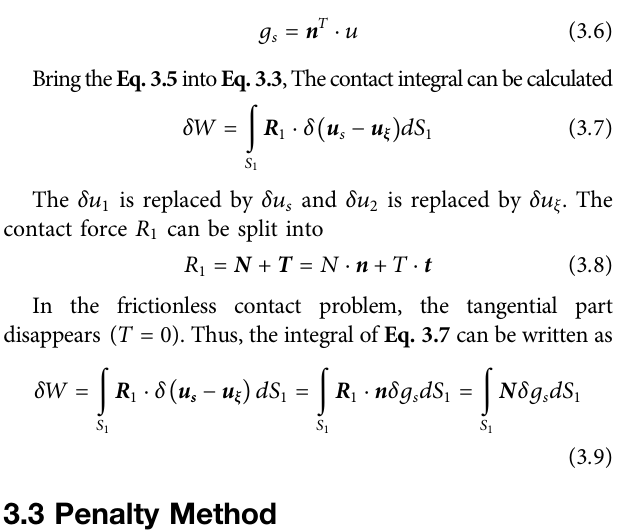
FIGURE 7 | The normal contact stress distribution ( σ yy ) along the contact zone. FIGURE 8 | Maximum normal contact stress under different numbers of